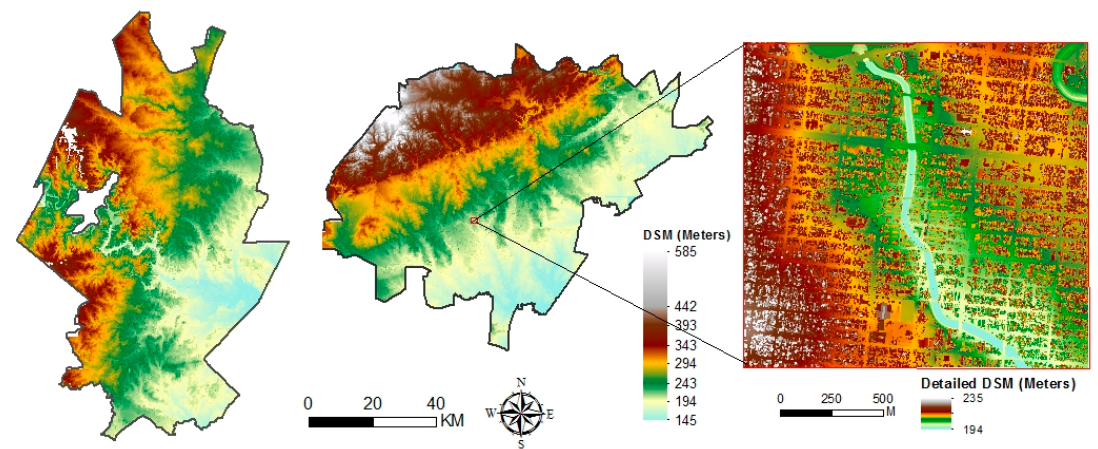
Figure 2. Digital surface models (DSMs) with a 5 m resolution for Austin ( left ), San Antonio ( middle ), and a detailed illustration of DSMs for a selected area of San Antonio ( right ).